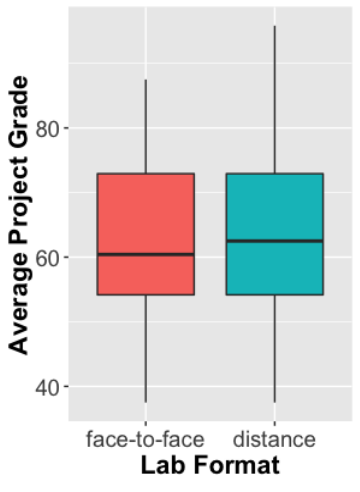
Figure 1 . Average project grades in the two lab